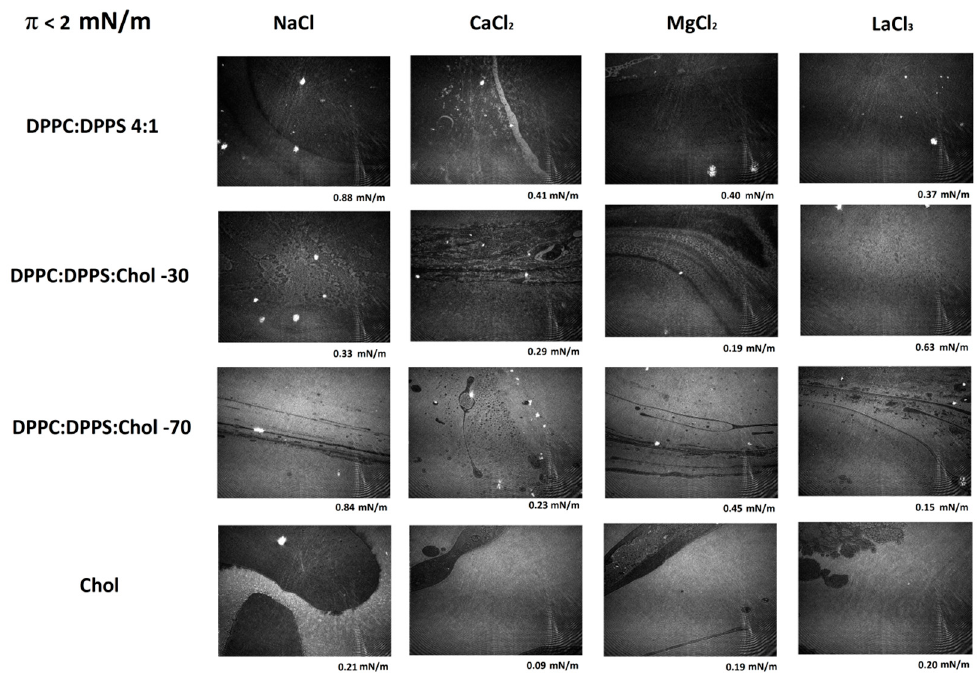
Figure 3. Micro-Brewster Angle Microscopy (Micro-BAM) images of the effect of electrolyte on DPPC:DPPS:CHOL monolayers at low compression states ( π < 2 mN/m). The images correspond to the π - A isotherms plotted in Figure 1.